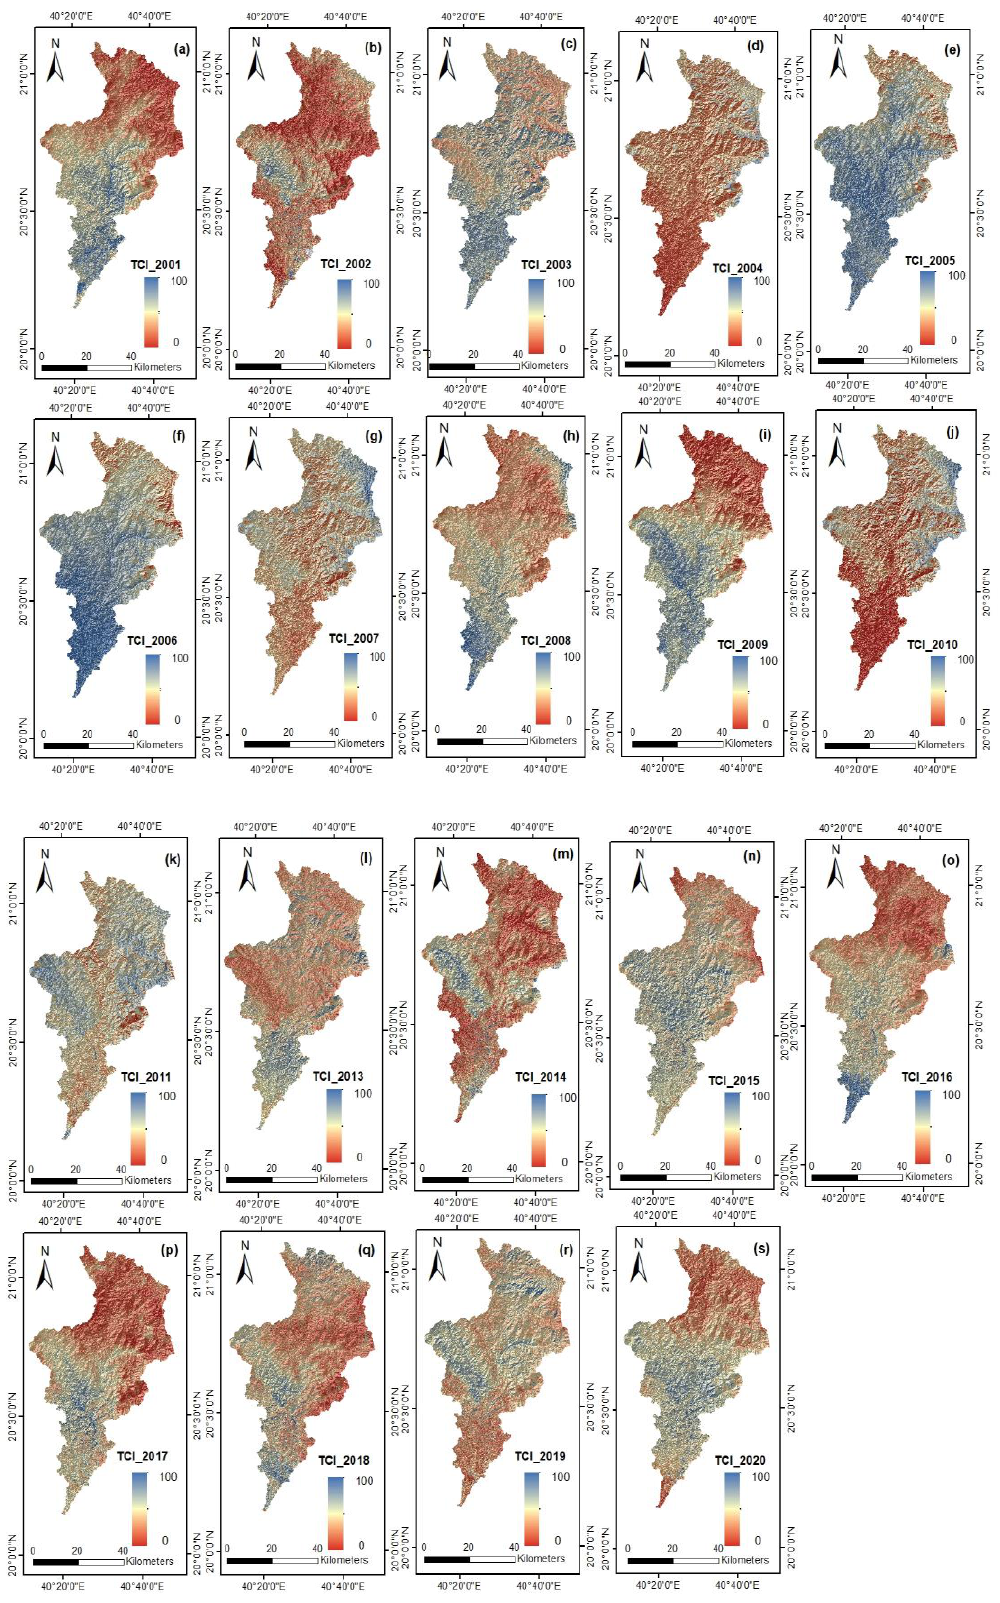
Figure 6 . ( a – s ) Spatial distribution of TCI in Al-Lith Watershed retrieved from Landsat Satellites for the period of 2001 – 2020.